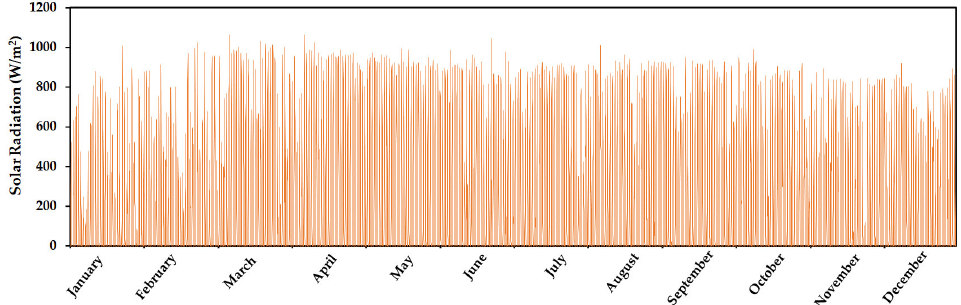
Figure 2. Hourly solar radiation in Rogongon, Iligan City.